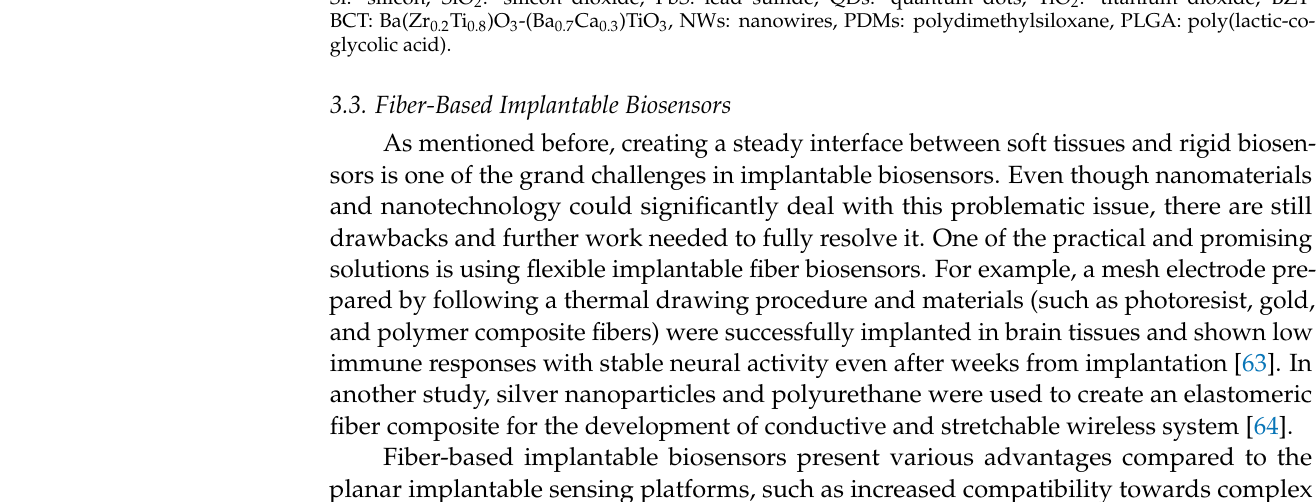
Table 2. Nanomaterials in the fabrication of implantable biosensing platforms. Outcome Ref. Ultra-sensitive electrochemical impedance biosensor for detection of streptavidin. Round diaphragm pressure sensors. Nano-implant for neural tissues monitoring, diagnosis, and treatment. Early-stage cancer diagnostics and treatment of ophthalmic diseases. Implantable retinal